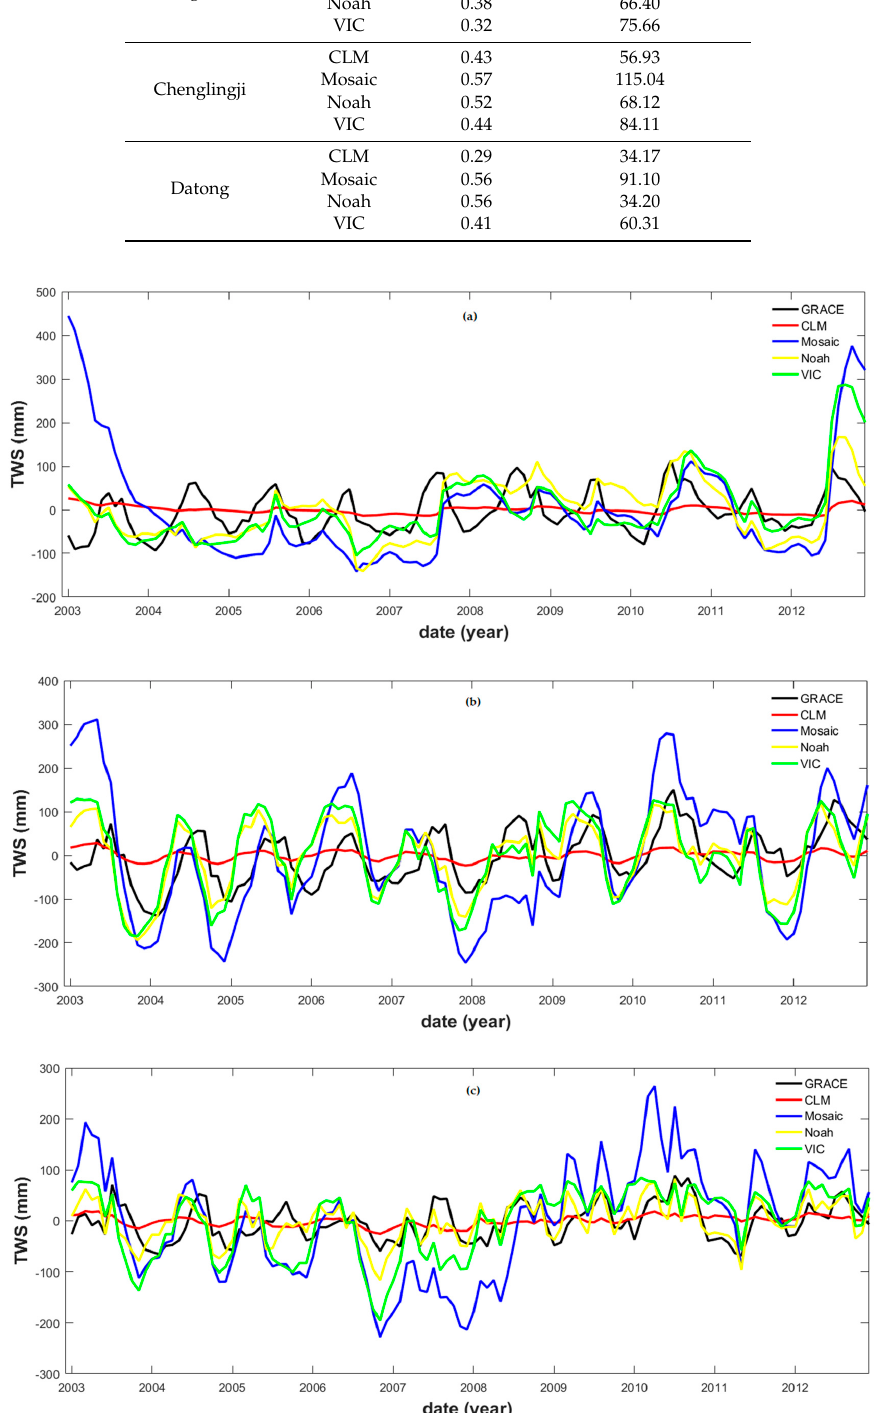
Figure 6. GRACE terrestrial water storage and the GLDAS-modeled time series in correspondence of ( a ) Pingshan (upper reaches), ( b ) Chenglingji (middle reaches), and ( c ) Datong (lower reaches)